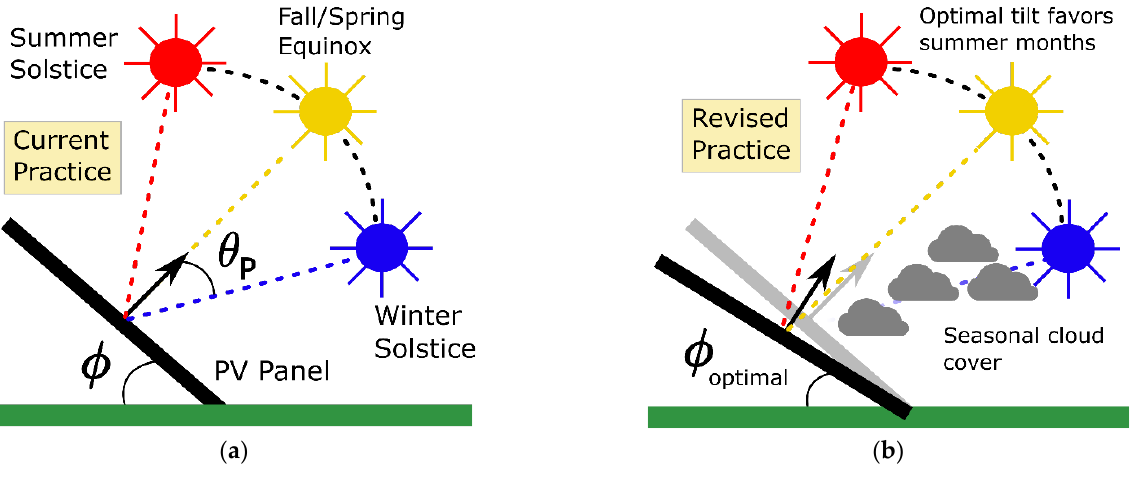
Figure 1. ( a ) A depiction of a commonly accepted practice for deploying PV panels, where the tilt angle is equivalent to the latitude of the PV panel geographic location. ( b ) A revised practice where the PV tilt angle is revised to reflect seasonal weather patterns and seasonal variations in daylight hours.